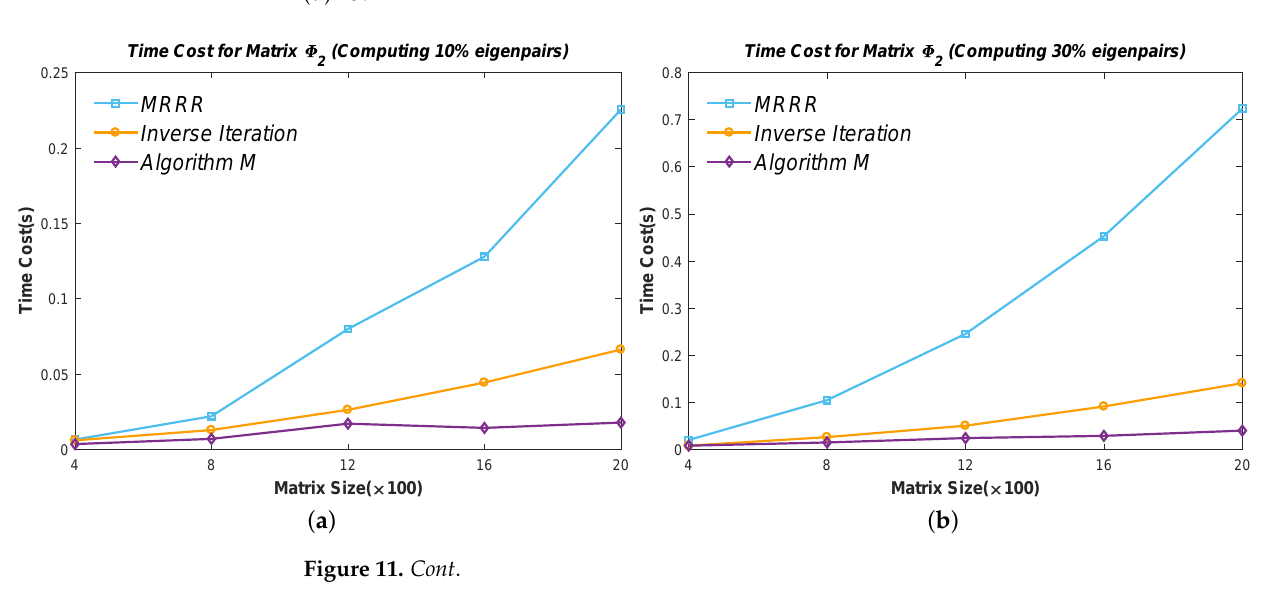
Figure 10. The time cost for Matrix Φ 1 when calculating part eigenpairs: ( a ) 10%; ( b ) 30%; ( c ) 50%; ( d ) 70%.